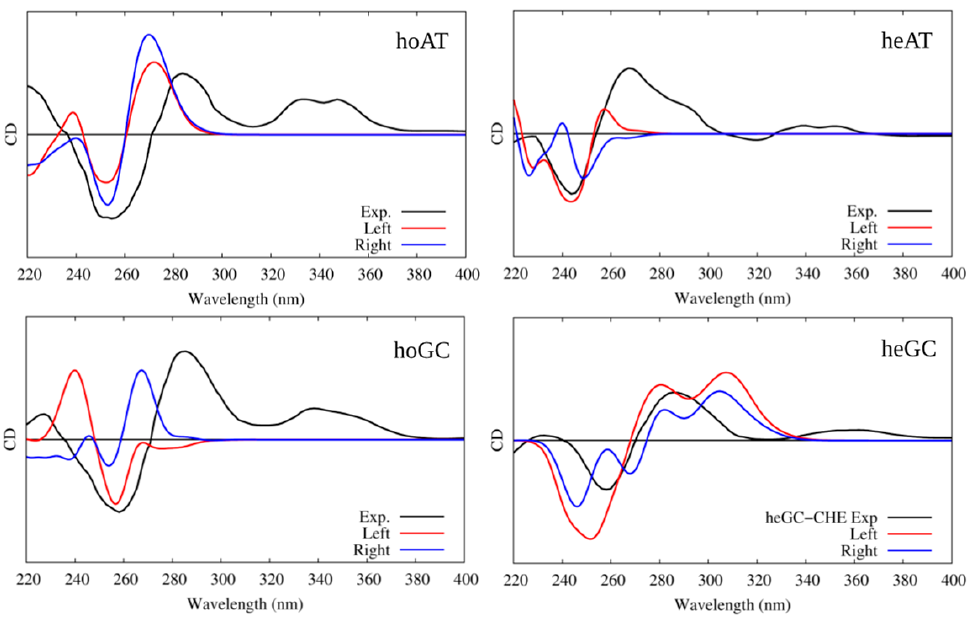
Figure 4. Experimental and simulated electronic circular dichroism (ECD) spectra of CHE in the presence of B-DNA; intensities are reported in arbitrary units. The black line represents the experimental spectrum uniformly scaled to match the values of the convoluted one. The red line represents the simulated spectrum for CHE in the left orientation, while the blue one represents the simulated ECD of CHE in the right orientation. Note that the CHE absorption contribution was not considered in the calculated spectra .